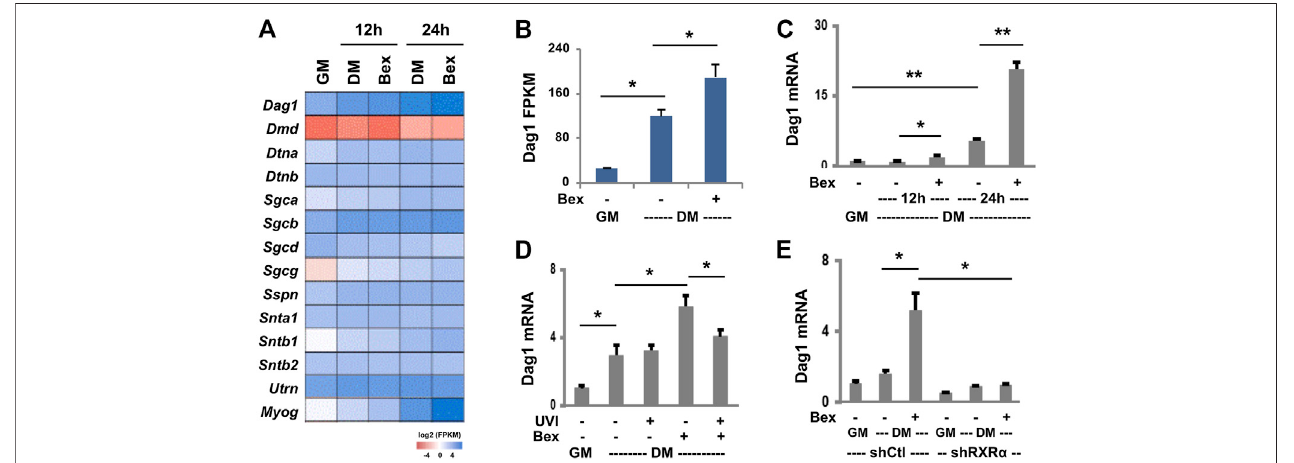
FIGURE 1 | RXR-selective signaling augments Dag1 expression. (A) C2C12 myoblasts were differentiated (DM) in the absence or presence of bexarotene (Bex, 50 nM) for 12 or 24 h and then subjected to RNA-seq analysis in duplicate with proliferating myoblasts as control (GM). Heat map of bexarotene-responsive Dag1 gene expression withothercomponentsofDGCandmyogenininparallelasacomparison. (B) Quanti fi cationof Dag1 readsignalsat24 hofdifferentiationisplottedasFPKM (fragments per kilobase of transcript per million mapped reads, * p < 0.05). (C) Primary myoblasts were differentiated with bexarotene (Bex, 30 nM). The relative levels of Dag1 mRNA were determined byRT-qPCR and presented as fold changes in relation to proliferating primary myoblasts, after being normalized to Rps26 (** p < 0.01; n = 3). (D) The C2C12 myoblasts were differentiated with bexarotene (50 nM) with or without RXR antagonist UVI3003 (UVI, 1 μ M) for 24 h. The relative levels of Dag1 mRNA were determined by RT-qPCR and presented as fold changes in relation to proliferating myoblasts, normalized to Rps26 ( n = 3). (E) shRXR α knockdown C2C12 myoblasts were differentiated for 24 h and subjected to RT-qPCR analysis. The relative levels of Dag1 mRNA were presented as fold changes in relation to proliferating myoblasts, normalized to Tbp ( n =